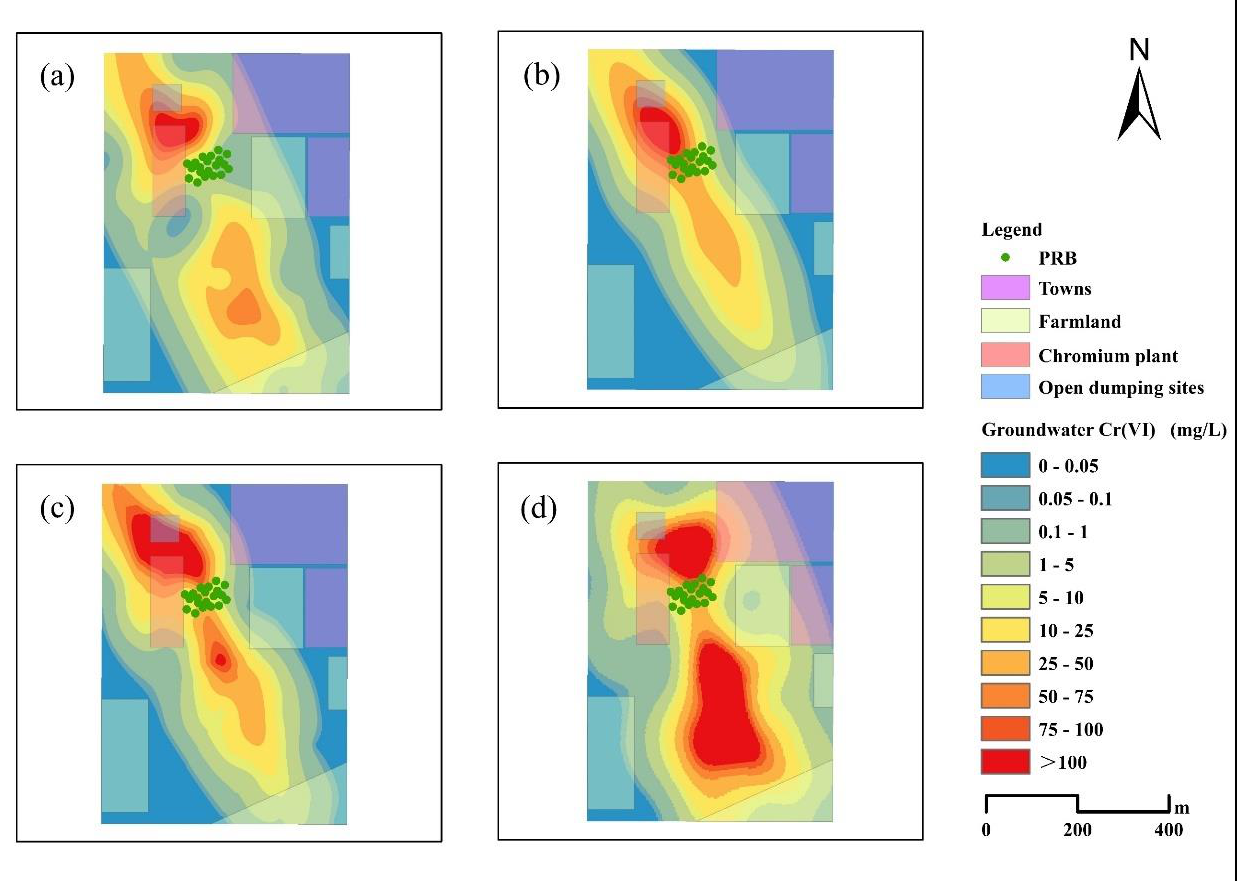
Figure 3. Spatial distribution of Cr(VI) in groundwater ( a ) Concentration distribution in September 2016 ( b ) Distribution of concentrations in April 2018 ( c ) Distribution of concentrations in January 2019 ( d ) Distribution of concentrations in May 2020.